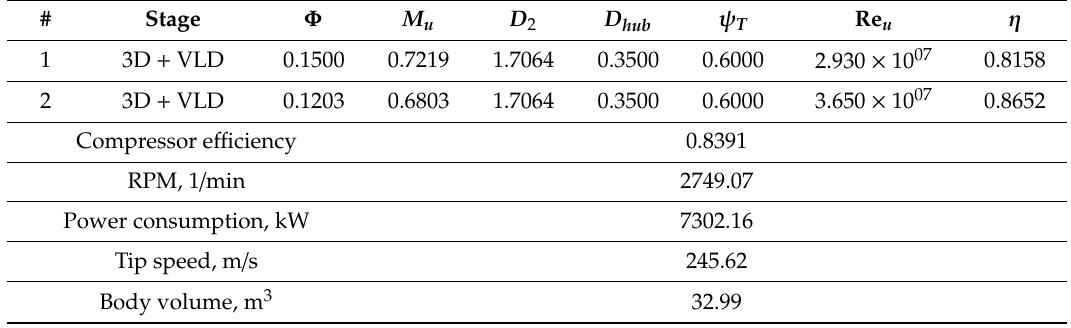
Table 1. PC software PDCC-G8E for variant calculation and preliminary design: main parameters of the selected compressor variant.